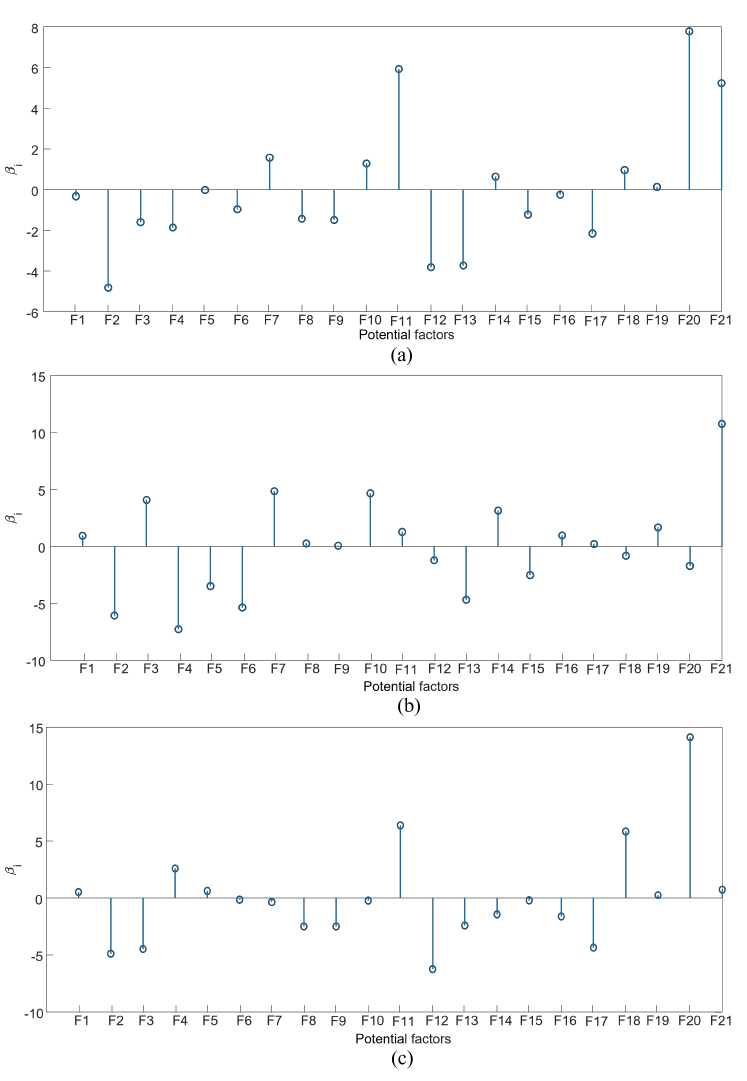
Figure 6. The regression coefficients with respect to the potential factors: ( a ) The data of the all participant; ( b ) the data of the student participants from the UCAS, first-class, and national key universities; and ( c ) the data of the student participants from the ordinary universities. The potential factors are denoted as follows: students understand what plagiarism is (F1), clear regulations on plagiarism in coursework (F2), penalization for plagiarism (F3), lecturers have highlighted